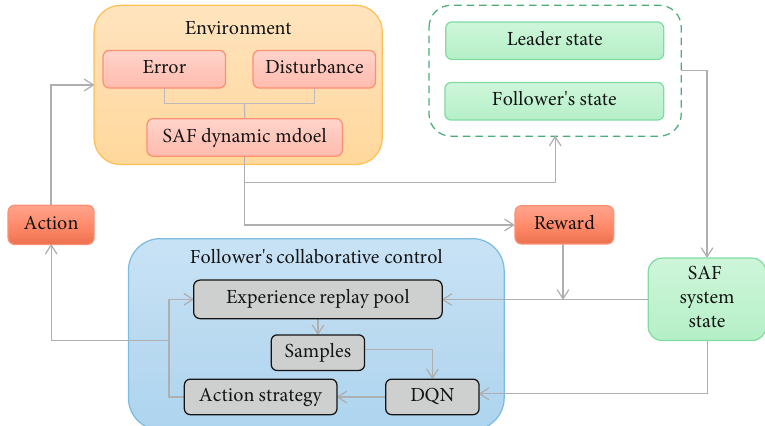
Figure 4: The DQN-based control algorithm framework of the SAF collaborative